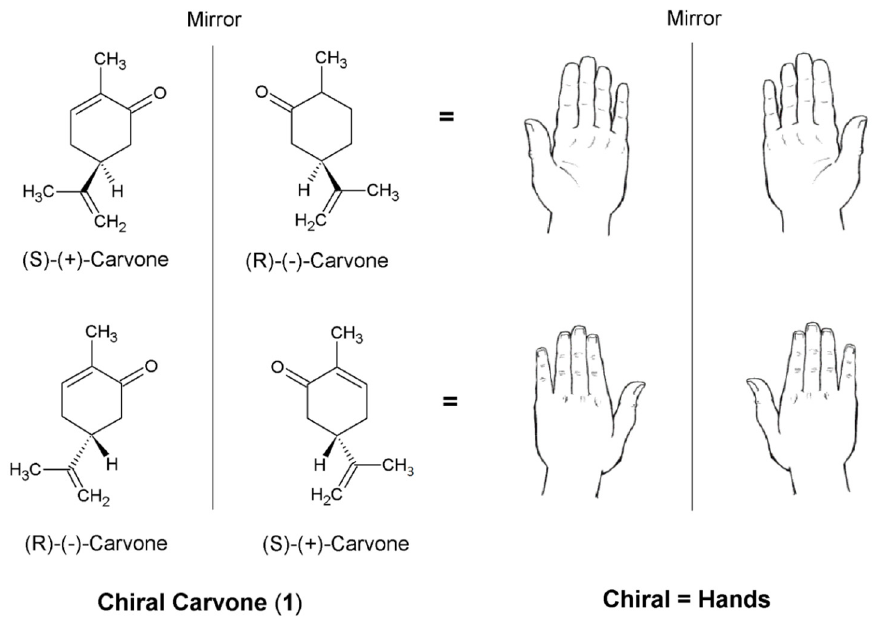
Figure 2. The two enantiomers of a carvone ( 1